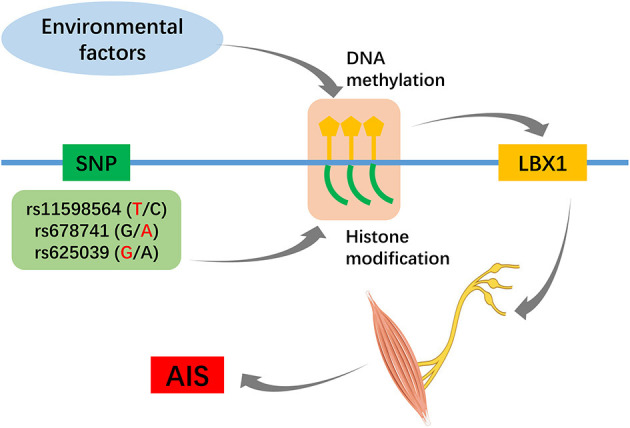
Hypothesis of susceptibility loci and epigenetic factors jointly regulate the LBX1 gene.